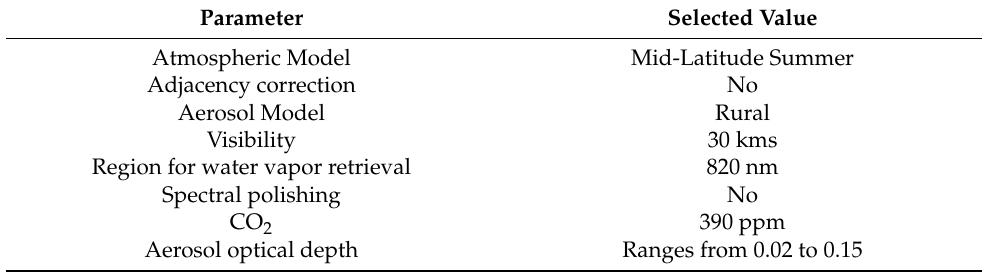
Table 3. FLAASH parameters .